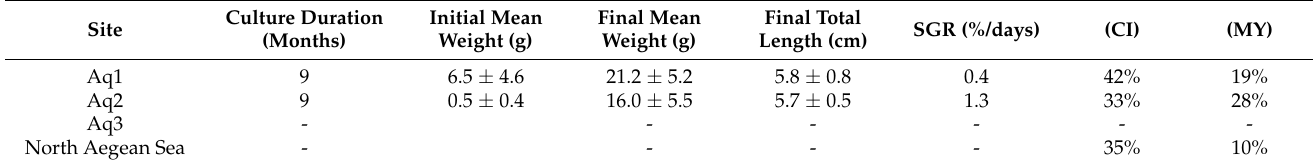
Table 2. Culture duration, initial total weight, final total weight, final total length, specific growth rate (SGR), condition index (CI), and meat yield (MY) at three IMTA farms of the Mediterranean mussel (Aq1: Epidauros, Aq2: Evoikos, Aq3: Rhodes) and CI and MY of the Mediterranean mussel under natural conditions in the North Aegean Sea